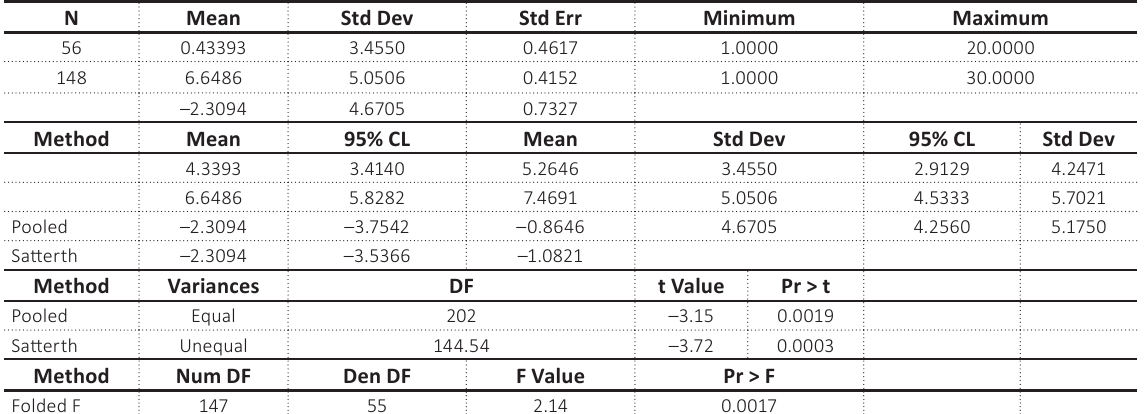
Source: Authors’ processing using SAS